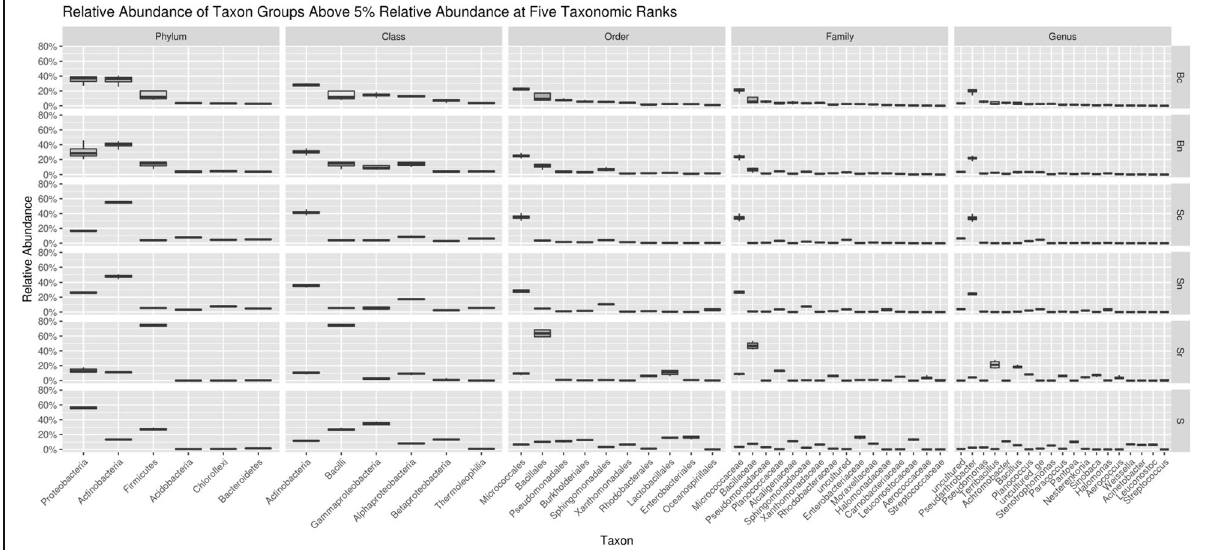
Fig. 6 Relative abundance of taxon groups above 5% at five taxonomic ranks. Each boxplot in the figures indicated the range of bacteria genera observations in each sample, with the box denoting the interquartile range (IQR) between the first and third quartiles (i.e., 25th and 75th percentiles, respectively) and the vertical line inside the box defined the median. In order to better show the difference in bacterial species between the groups, more than 5% of all samples (six groups), in any one group, were counted (from phylum to genera) and